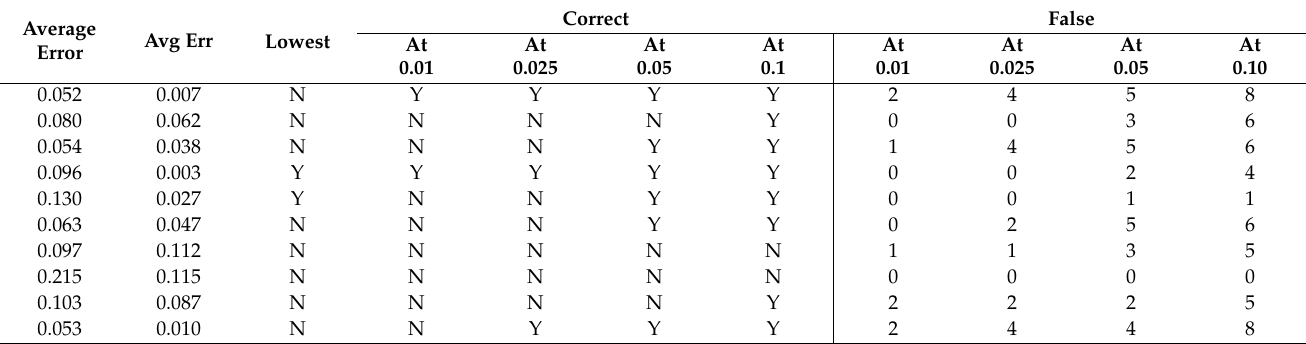
Table A138. Set 2, trials 31–40 summary data (actual PR value).